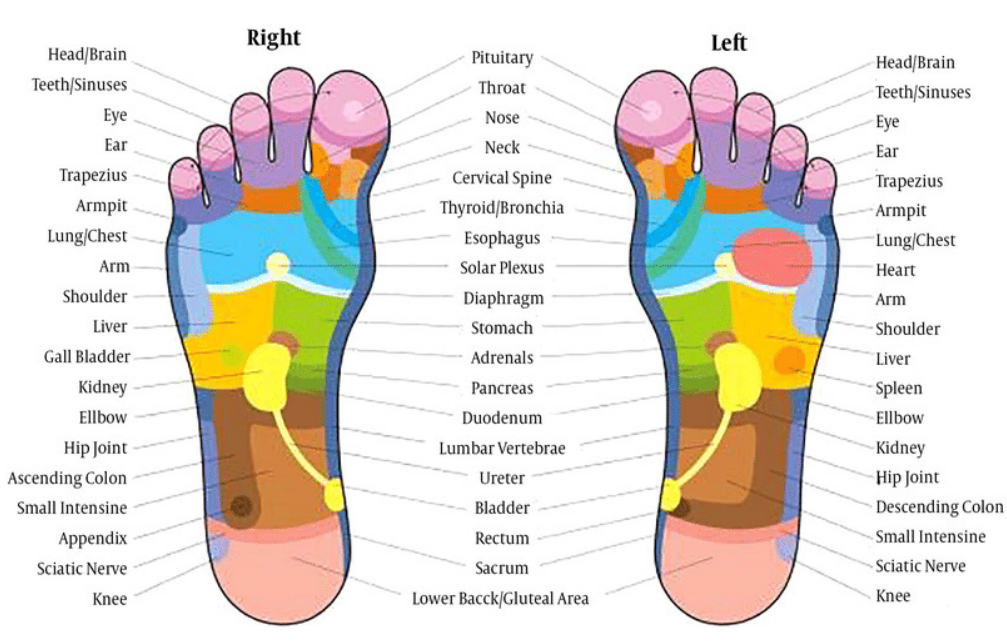
Figure 1. Foot reflexology chart.